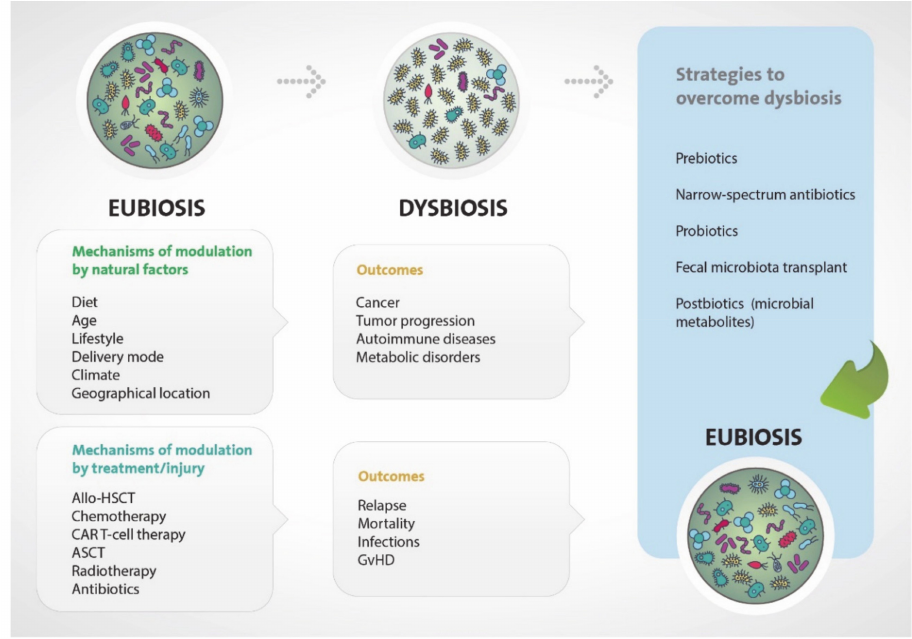
Figure 2. Mechanisms of gut microbiota modulation, consequences, and potential